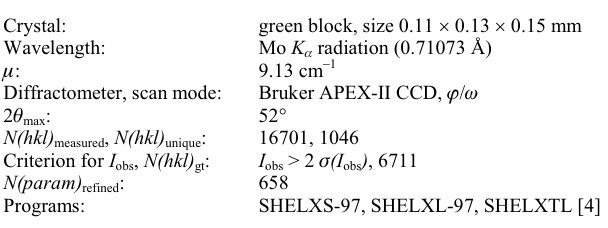
Table 1. Data collection and